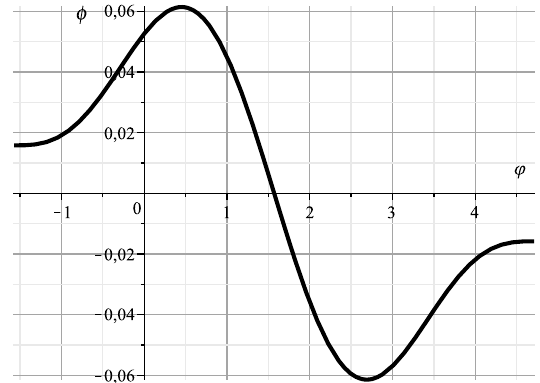
Figure 34: Plot of ϕ ( φ ) (Example 5.4).